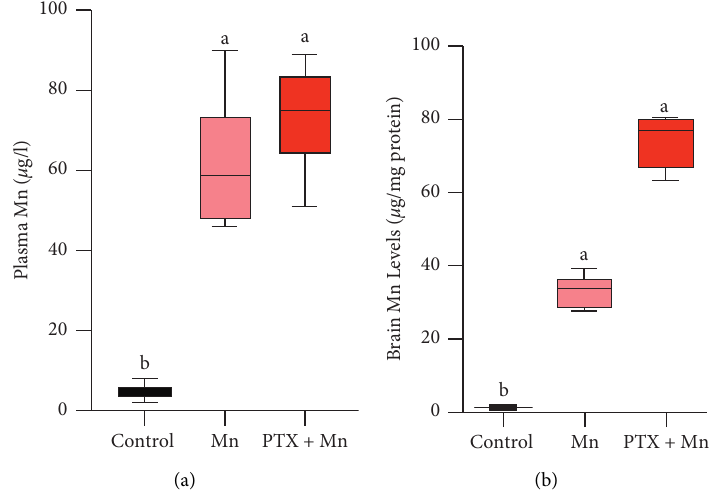
Figure 4: The effects of PTX on the amounts of plasma (a) and brain (b) Mn level in the studied groups. Data are represented as mean ± SD. According to the post hoc Tukey test, groups with the same superscripted letters were not significantly different at α � 0.05 ( P ≥ 0 . 05 ) . However, dissimilar letters indicate a significant difference ( P < 0 . 05 )